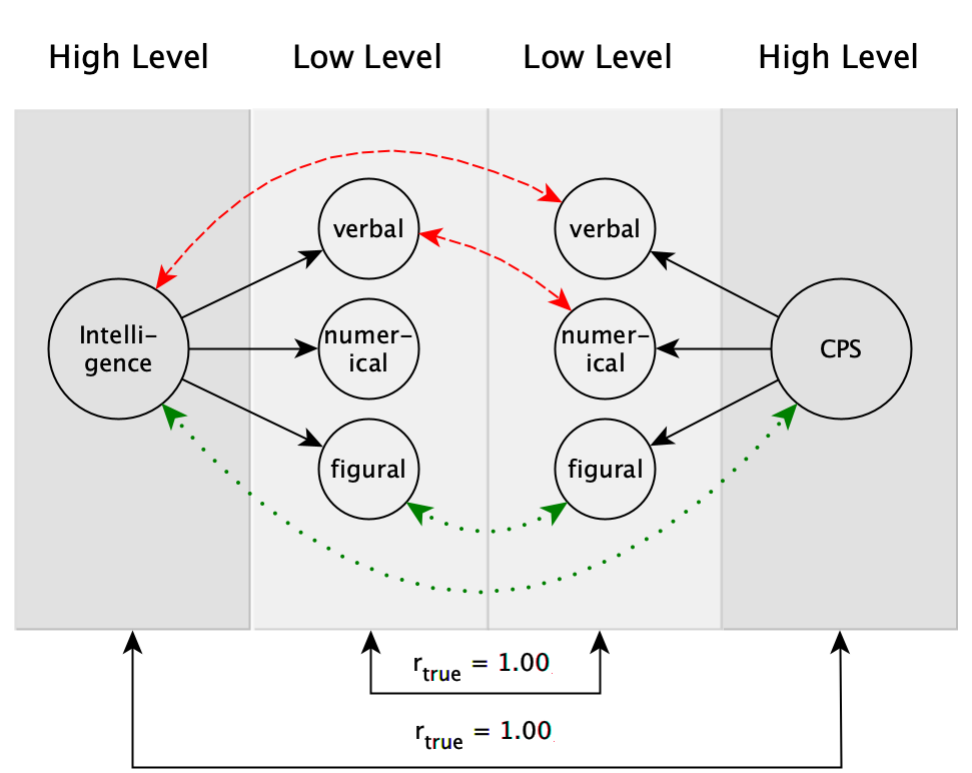
Figure 1. Illustration of the Brunswik symmetry principle according to Wittmann (1988). Dotted (green) lines = symmetrical (fair) comparison; dashed (red) lines = asymmetrical (unfair)